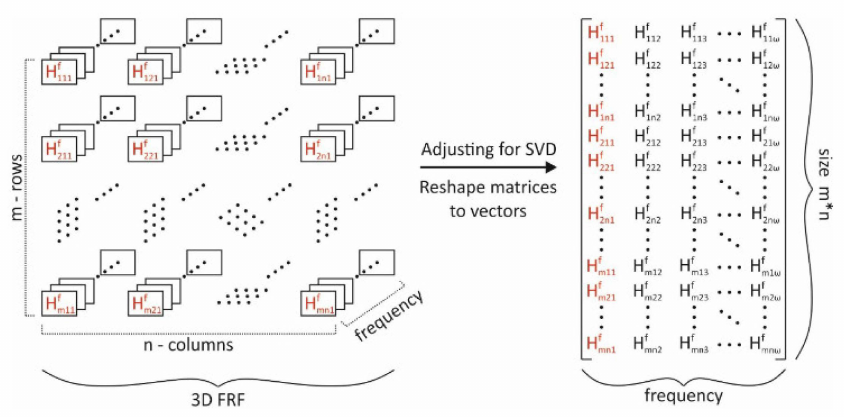
Figure 11. Transformation of the FRF matrix into vector notation. By plotting the singular values on the frequency axis, a singular waveform was obtained whose peaks indicated the presence of modes of oscillation (Figure 12). The respective frequencies of the individual peaks are the natural or resonant frequencies. For each natural frequency, there is an intrinsic mode of oscillation. The eigenmodes of oscillation are exported for the selected frequency from the FRF matrix.